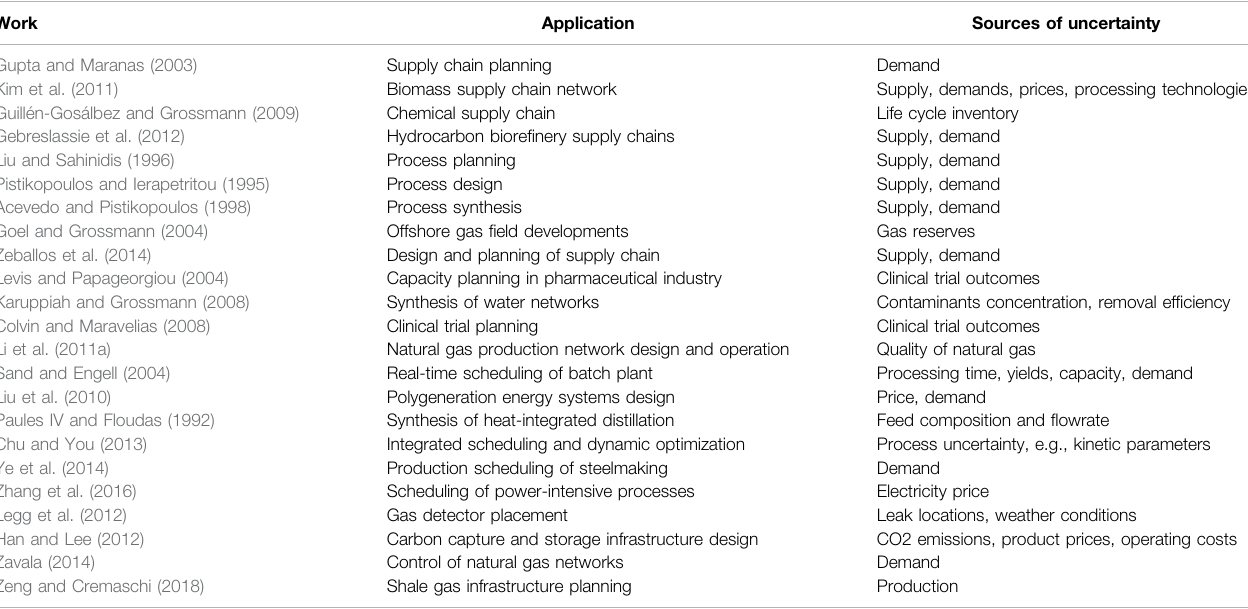
TABLE 1 | Summary of representative works that use stochastic programming for PSE